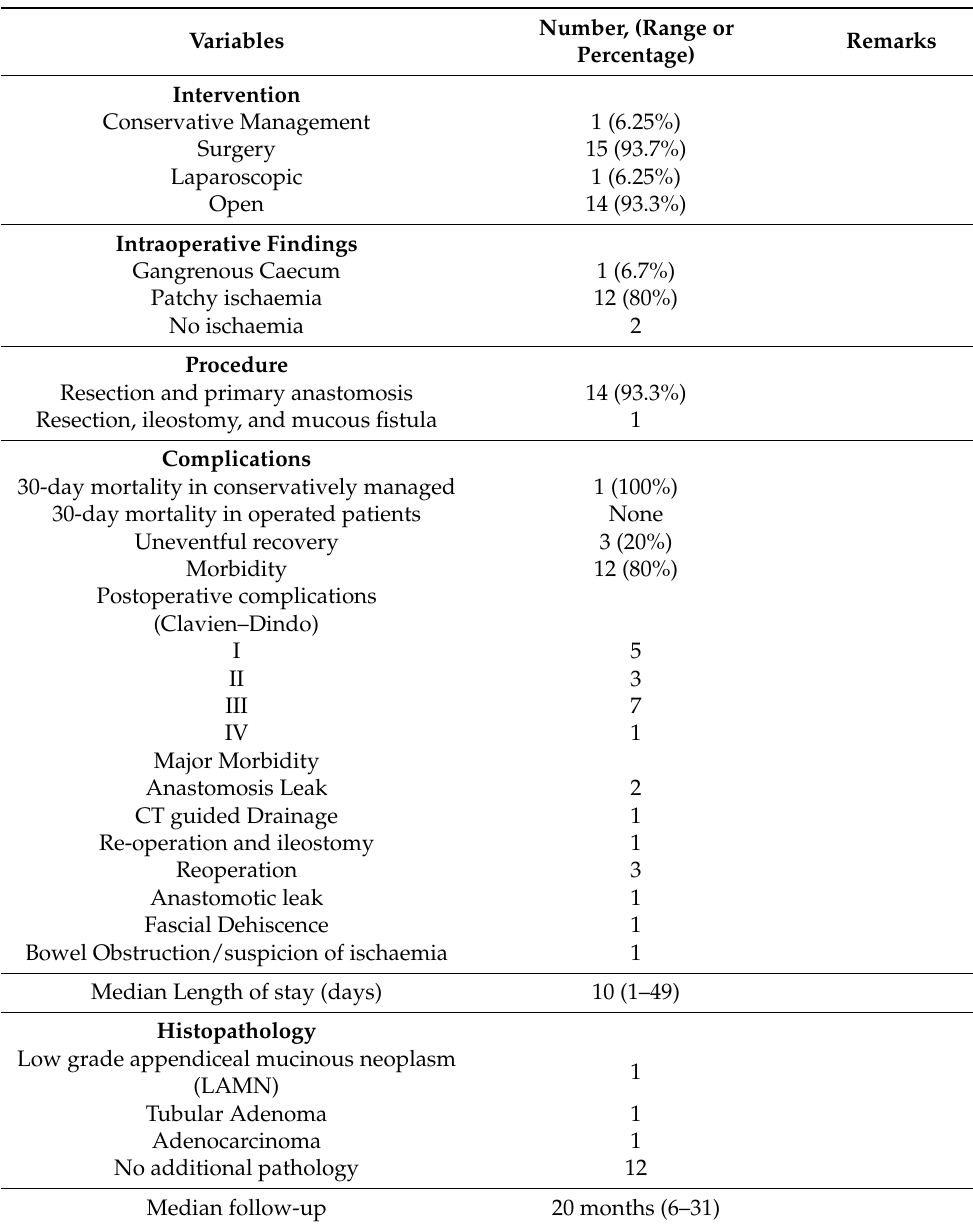
Table 4. Peri-operative